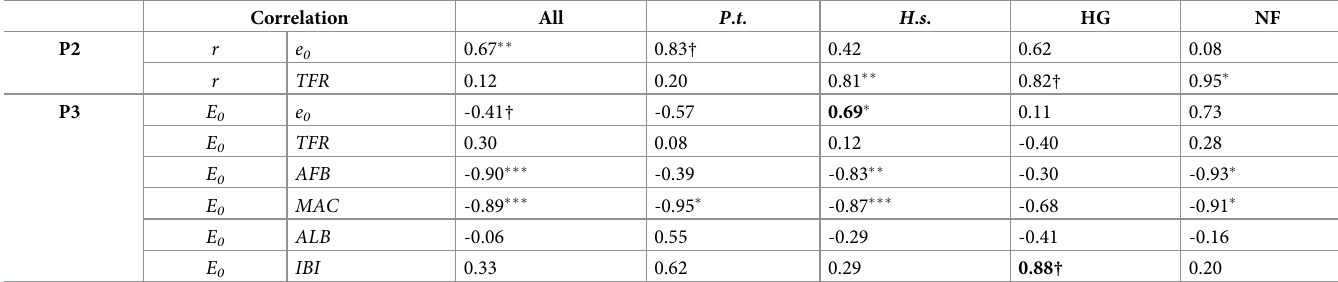
these measures can differ widely (Fig 3A vs. 3B), the ratio of effect:potential is a useful metric to help inform us about the tradeoffs constraining life history evolution. Although elasticities predicted that child survival would contribute greatly to fitness differences, these rates did not account for as high a proportion of observed effects among humans as predicted on the basis of elasticities alone ( E vs. C , Fig 3). Adult survival effects were overestimated by elasticities c c (i.e., Z << 1 because C << E ) even more than juvenile survival effects among chimpanzees ( Z > Z ; p = 0.016) and (marginally) more among non-foragers ( Z > Z ; p = 0.095). Across c a c a all populations, fertility effects were grossly underestimated by elasticities ( Z << Z ; p = 0.008; c f Fig 3; Table 2; S5 Table in S1 Data), hence all populations hover to the right of the elasticity ter- nary triangle (Fig 3A) but are more scattered in the fitness triangle (Fig 3B). P2. Consistent with P2, population growth ( r ) was positively correlated with life expectancy ( e ) across our two-species sample ( r = 0.67, p = 0.006) and (marginally) across chimpanzee 0 populations ( r = 0.83, p = 0.084), whereas population growth ( r ) and fertility ( TFR ) were posi- tively correlated across human societies ( r = 0.81, p = 0.004; r = 0.95, p = 0.014 [non-foragers]; r = 0.82, p = 0.090 [hunter-gatherers]; Table 3). Inconsistent with P2, population growth was Table 3. Life history correlations. Correlation All P . t . H . s